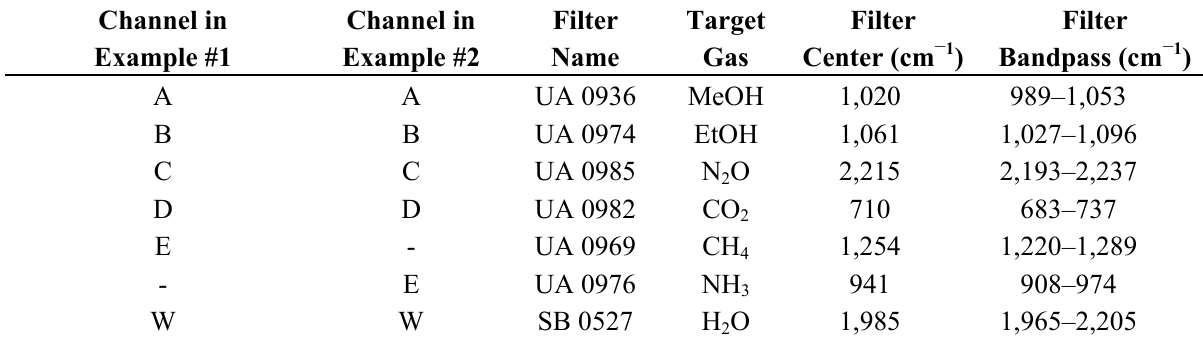
Table 1. Filter configurations and filter/target gas combinations in Example #1 and #2. Channel